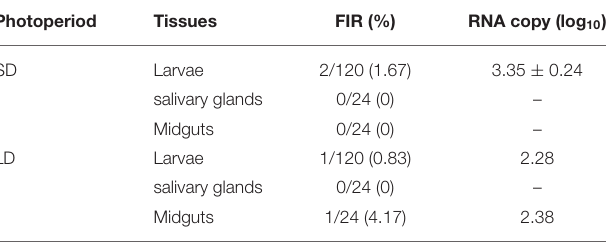
TABLE 1 | Zika virus infection of F1 progeny in the first gonotrophic cycle. Photoperiod